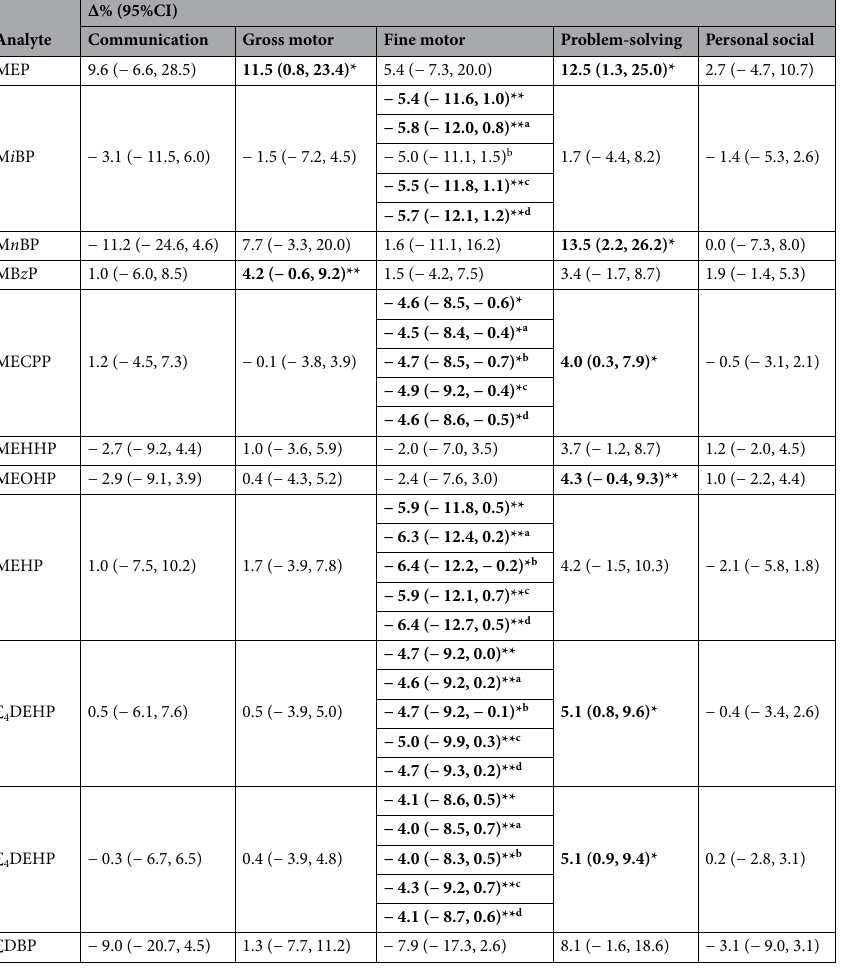
Table 6. The adjusted relationship between ln-transformed ASQ-3 scores of infants at the age of 2-month and urinary phthalate metabolites (µg/g creat) and molar sums of the metabolites (µmol/g creat) measured before their discharge from the NICU. Data also expressed as percent change (Δ%) and their corresponding 95% confidence intervals (CI) in score for every one unit increase in the metabolite. Bold characters denoted significant associations. p < 0.05; ** p < 0.1 Each linear regression model was adjusted for phthalate metabolite levels in urine taken at admission, birth body weight and length of stay in the NICU. Regression model was further adjusted for a respiratory distress syndrome; b intraventricular hemorrhage; c premature prolonged rapture of the membrane; d retinopathy of